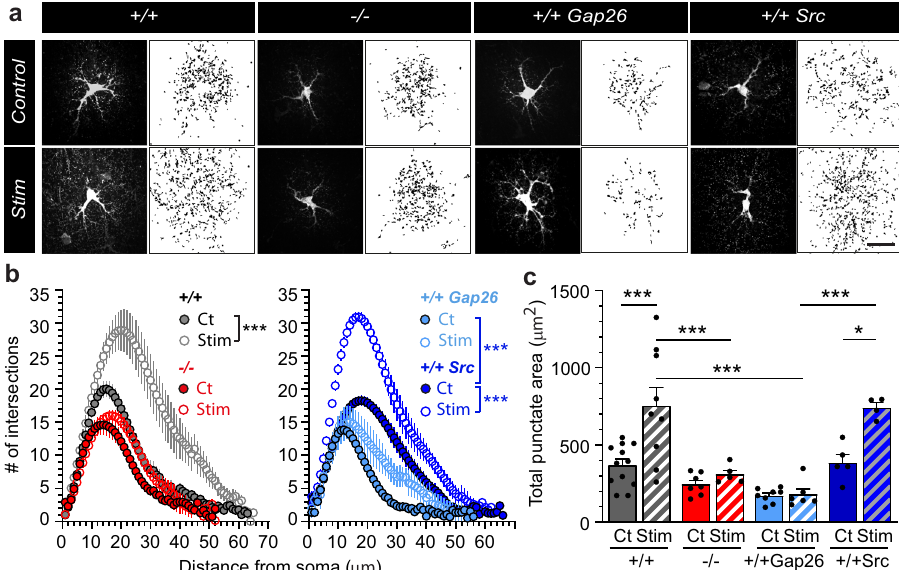
Fig. 8 Cx43 hemichannels mediate activity-dependent transfer of glutamine from astrocytes to synapses. a Representative confocal (dark background) and thresholded binary (white background) images of hippocampal CA1 astrocytes dialyzed with RhGln (0.8 mM, 20 min) via the patch pipette under control or stimulated (10 Hz, 30 s every 3 min for 20 min) conditions in acute slices obtained from: wild-type mice ( + / + ), glial conditional Cx43 knockout mice ( − / − ) or wild-type mice exposed to Gap26 ( + / + Gap26) or Gap26 scramble ( + / + Src) peptides. The binary images were quanti fi ed by Sholl analysis ( b ) and total punctate area ( c ). In + / + mice, repetitive synaptic stimulation strongly increased the punctate RhGln-labeling compared to control as shown by both Sholl analysis ( + / + : Ct, n = 12; Stim, n = 9, p < 0.0001, two-way ANOVA in b ) and total punctate area ( p < 0.0001 between Ct and Stim in + / + , one-way ANOVA with Bonferroni ’ s post hoc test in c ). This was abolished in − / − mice ( − / − : Ct, n = 7; Stim, n = 5, p = 0.0826, two-way ANOVA in b ; p > 0.999 between Ct and Stim in − / − , and p = 0.0002 between + / + Stim and − / − Stim, one-way ANOVA with Bonferroni ’ s post hoc